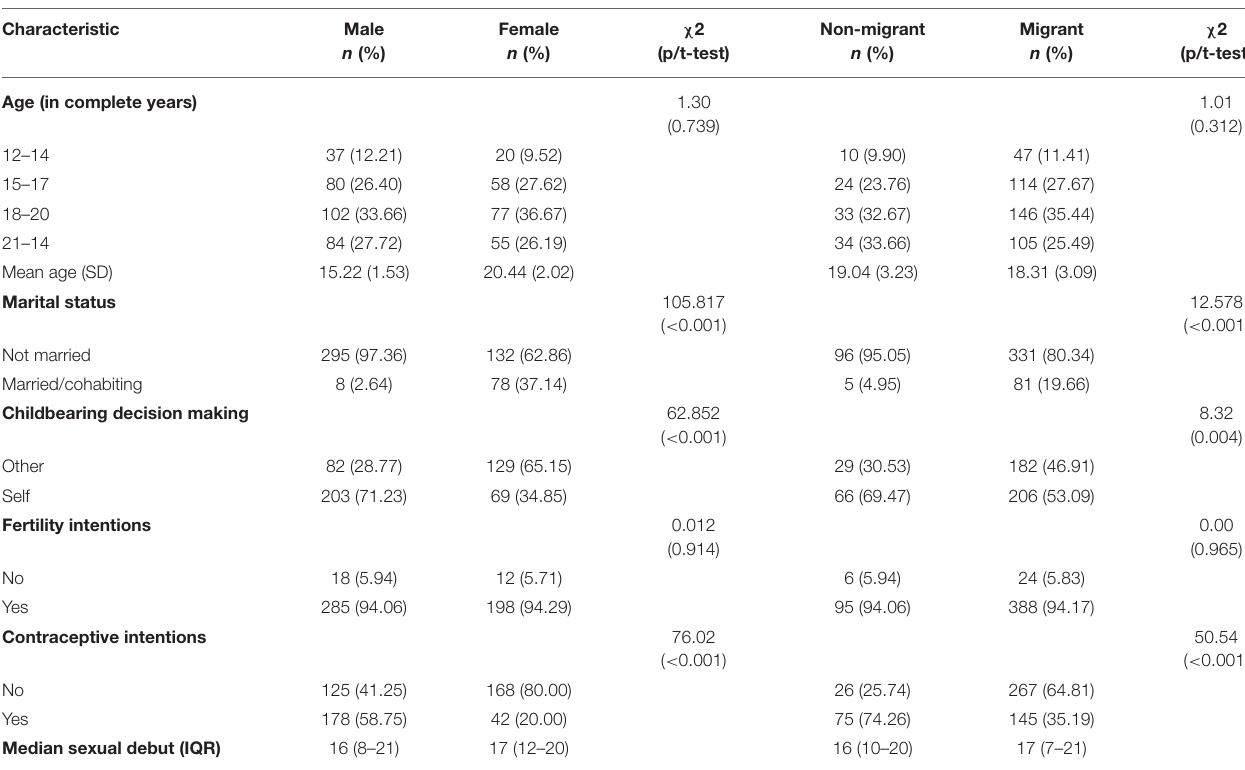
TABLE 1 | Crosstabulation of socio-demographics, childbearing decision-making, fertility, and contraceptive intentions among street adolescents and youth by sex and migration status, Kampala, Uganda, 2019.